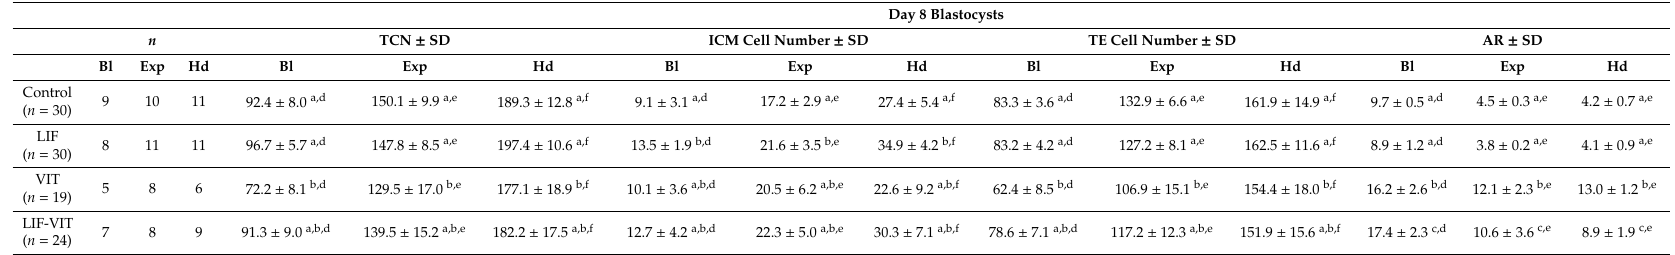
Table 2. TCN, number of cells in the ICM, TE and AR of Day 8 blastocysts derived from oocytes in vitro matured in media supplemented with LIF prior to vitrification / warming.